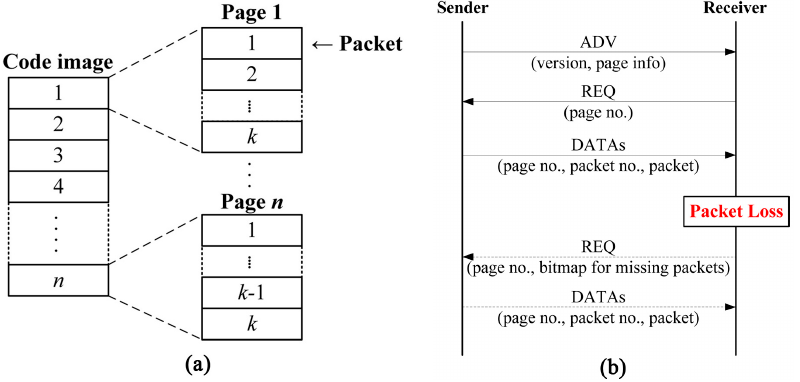
Figure 1. An illustration of Deluge: ( a ) The structure of pages and packets; ( b ) The operation of three-way handshake.